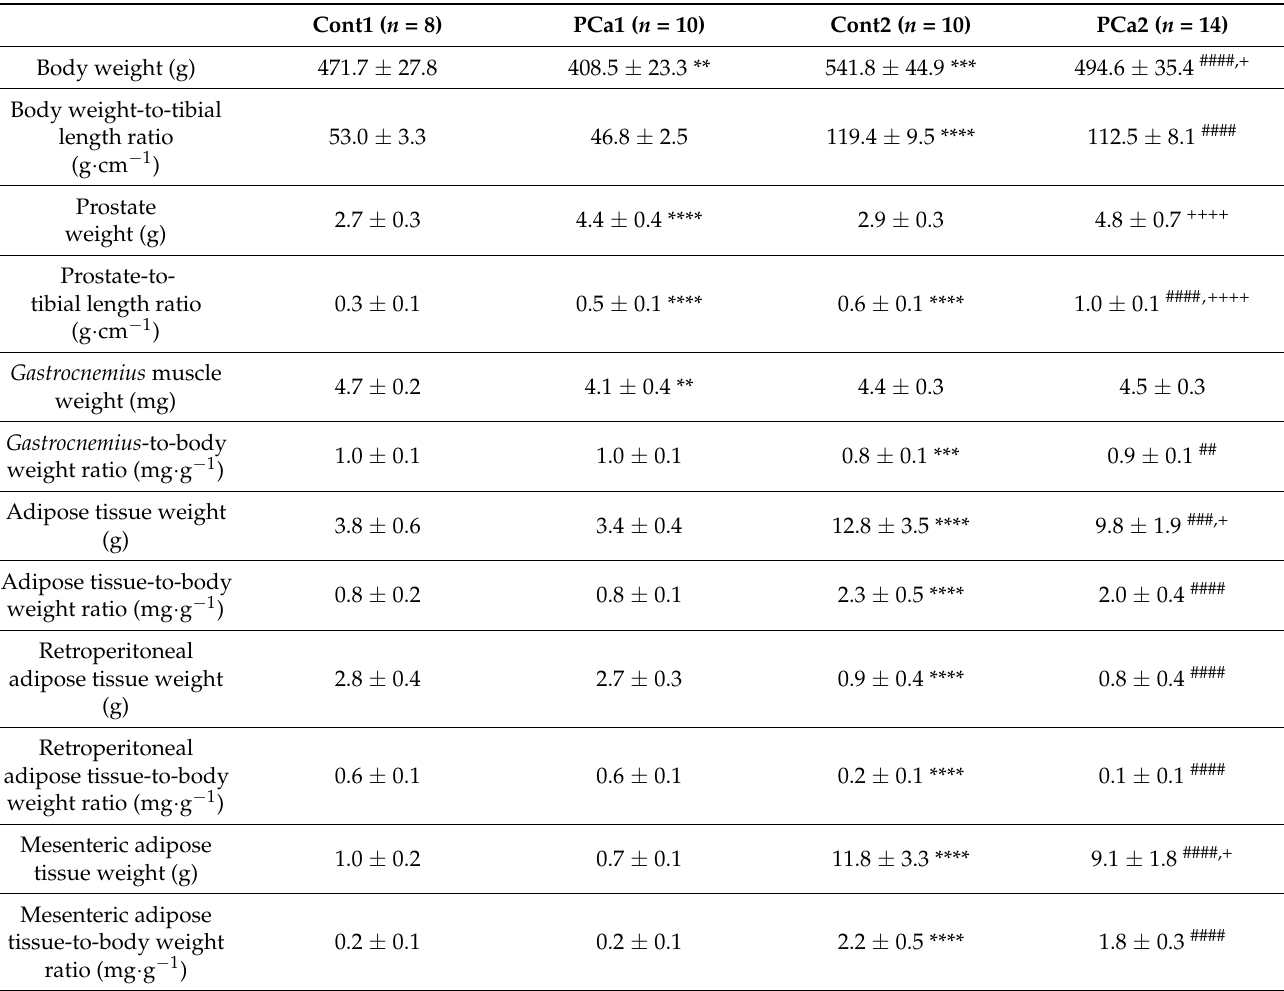
Table 1. Effect of prostate cancer on anthropometric data. Values are expressed as mean ± standard deviation. Cont1 ( n = 8) PCa1 ( n = 10) Cont2 ( n = 10) PCa2 ( n =